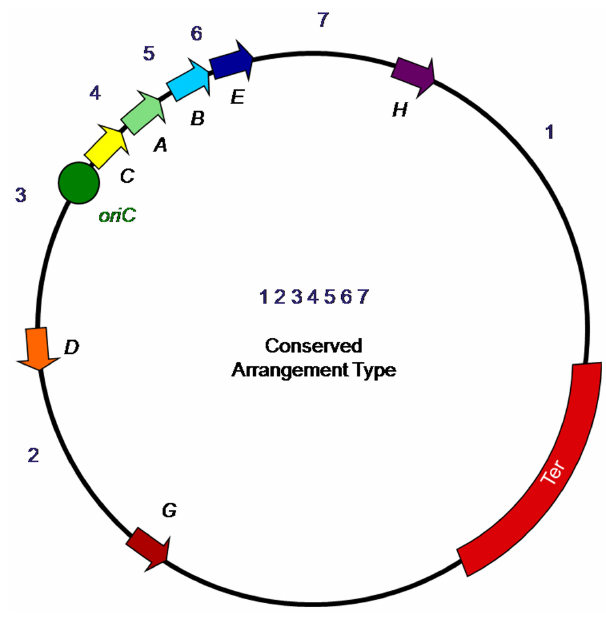
Figure 1. The conserved rrn arrangement type 1234567 found in the broad host range serovars of Salmonella enterica . The seven rrn operons are lettered while the regions in between the operons are numbered. The origin of replication is indicated by a green circle and the terminus region is highlighted in red. Replichores are the chromosomal halves between the origin and terminus of replication.